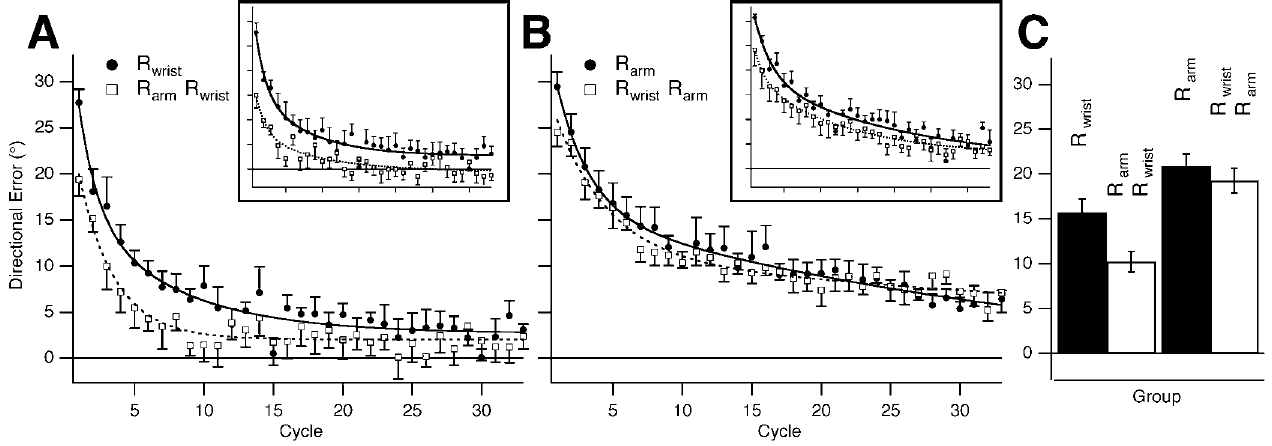
Figure 2. Savings Transfers from Arm to Wrist but Not from Wrist to Arm (A) R wrist on day 1 (group 1, black circles and black curve) and R wrist on day 2 after R arm on day 1 (group 5a, white squares and dashed curve). There were substantial savings from R arm on day 1 to R wrist on day 2. Inset: R wrist on day 1 (group 1, black circles and black curve) and R wrist on day 2 after R shoulder on day 1 (group 5b, white squares and dashed curve). There were substantial savings from R shoulder on day 1 to R wrist on day 2 (mean difference ¼ 7.75 8 , p ¼ 0.0157). Inset axes scaled as in main figure. (B) R arm on day 1 (group 5, black circles and black curve) and R arm on day 2 after R wrist on day 1 (group 4, white squares and dashed curve). There were no significant savings from R wrist on day 1 to R arm on day 2. Inset: R shoulder on day 1 (group 1, black circles and black curve) and R wrist on day 2 after R shoulder on day 1 (group 5b, white squares and dashed curve). There were no significant savings from R wrist on day 1 to R shoulder on day 2 (mean difference ¼ 4.5 8 , p ¼ 0.1). Inset axes scaled as in main figure. (C) First pair of bars showing a statistically significant difference in the reduction in mean directional error in the first six cycles for R wrist on day 2 , after R arm on day 1, compared to R wrist on day 1 (groups 1 vs. 5a, mean difference ¼ 5.52 8 , p ¼ 0.01). Second pair of bars showing no statistically significant difference in the reduction in mean directional error in the first six cycles for R arm on day 2, after R wrist on day 1, compared to R arm on day 1 (groups 5a versus group 4, mean difference ¼ 3.52 8 , p ¼ 0.12). DOI: 10.1371/journal.pbio.0040316.g002